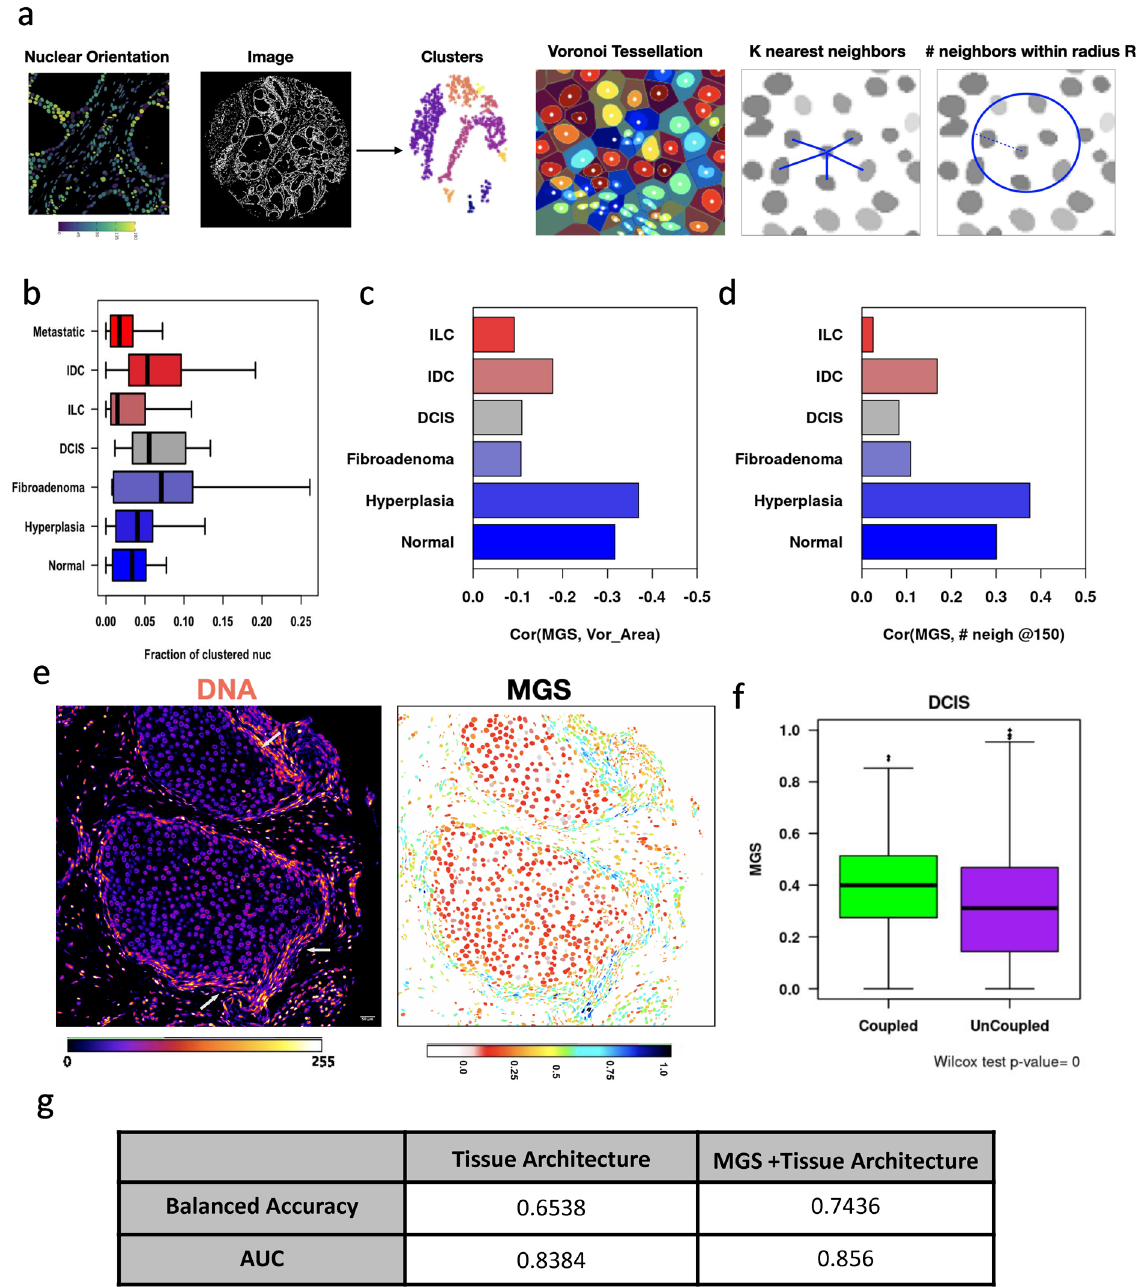
Figure 5. Orientationally coupled regions are characteristic of early breast cancer states. ( a ) Representation of the method used to identify orientationally coupled regions in the tissue. We first segment nuclei, obtain the angle that the major axis of the fitted ellipsoid makes with the X axis. We filter to obtain only elongated nuclei and then use their centroid and orientation as features for Density-based spatial clustering of applications with noise (DBSCAN). Each identified cluster is depicted in a different color. Local tissue density was calculated using multiple approaches namely, voronoi tessellation, distance to the kth nearest neighbour and number of neighbors in a given radius. ( b ) Fraction of clustered nuclei in the various stages of breast cancer. One way ANOVA indicated that there were significant changes in the means (p < 0.01). Correlation coefficient between MGS and Voronoi cell area ( c ) and number of neighbours in 40 µm radius ( d ). ( e ) Representative images showing the mechanically coupled regions (arrows) and the MGS of nuclei in Ductal Carcinoma in situ. ( f ) Mechano-Genomic Score (MGS) of clustered/coupled nuclei (green) and unclustered/uncoupled nuclei (purple) in Ductal Carcinoma In situ (DCIS) TMAs. ( g ) Tissue level predictions by Linear Discriminant Analysis using Tissue Architecture features with and without Mechano-Genomic